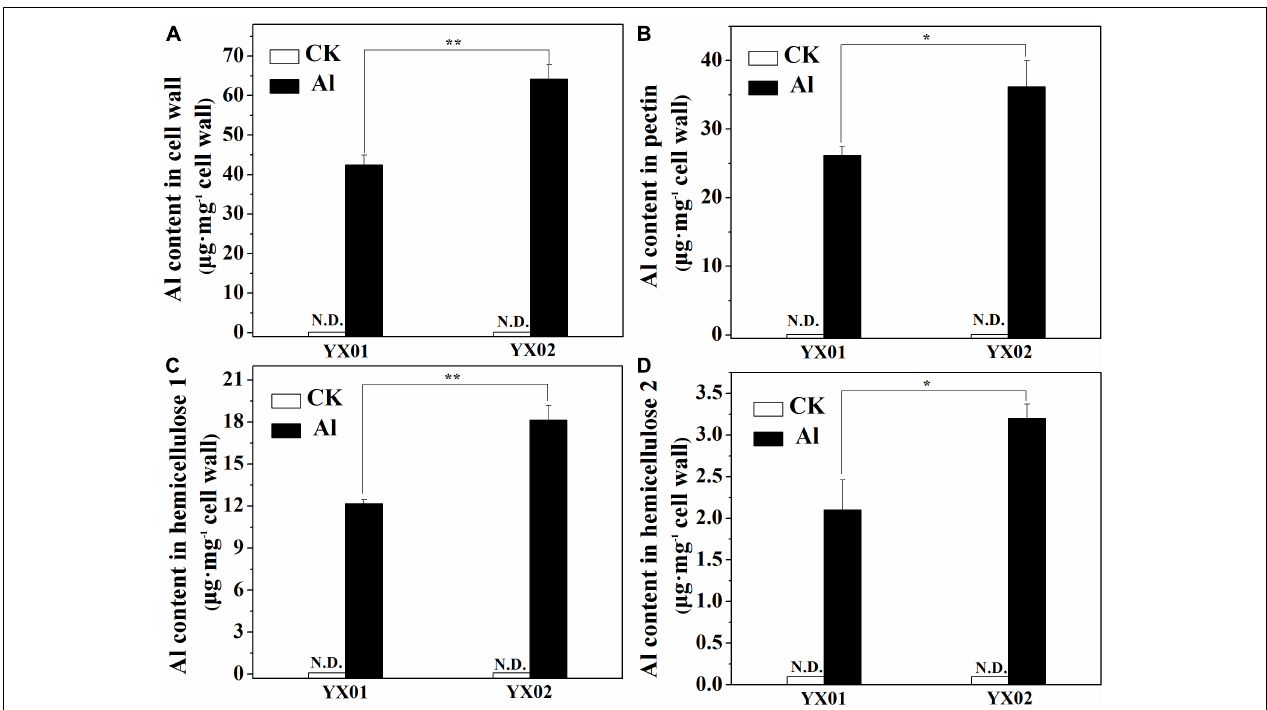
FIGURE 4 | Effects of Al treatment on Al content in cell wall (A) , pectin (B) , hemicellulose 1 (HC1) (C) and hemicellulose 2 (HC2) (D) of Chinese fir seedlings. Two-month-old Chinese fir seedlings were exposed to 1/2 strength complete nutrition solution without Al (CK), or with 1 mM AlCl 3 (Al) for 16 d. After treatment, cell wall was extracted from root tips of Chinese fir and fraction into pectin, HC1, and HC2 for Al content determination. Bars are means of four replicates ± SD. Different letters above histogram represent significant differences at P < 0.05 . * or ** above lines represent significant differences between genotypes at P < 0.05 and P < 0.0 1, respectively. N.D. indicates not